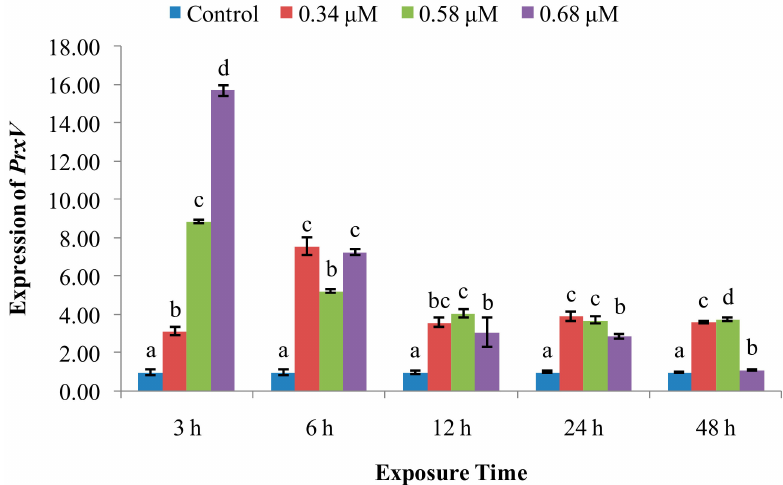
Figure 7. E ff ect of TD 49 on hemolymph expression of PrxV at di ff erent time points after exposure to di ff erent concentrations (0, 0.34, 0.58, 0.68 µ M) of TD 49 . Data represent mean ± SD values ( n = 3) at the same time interval, with di ff erent letters denoting significant di ff erences ( p <